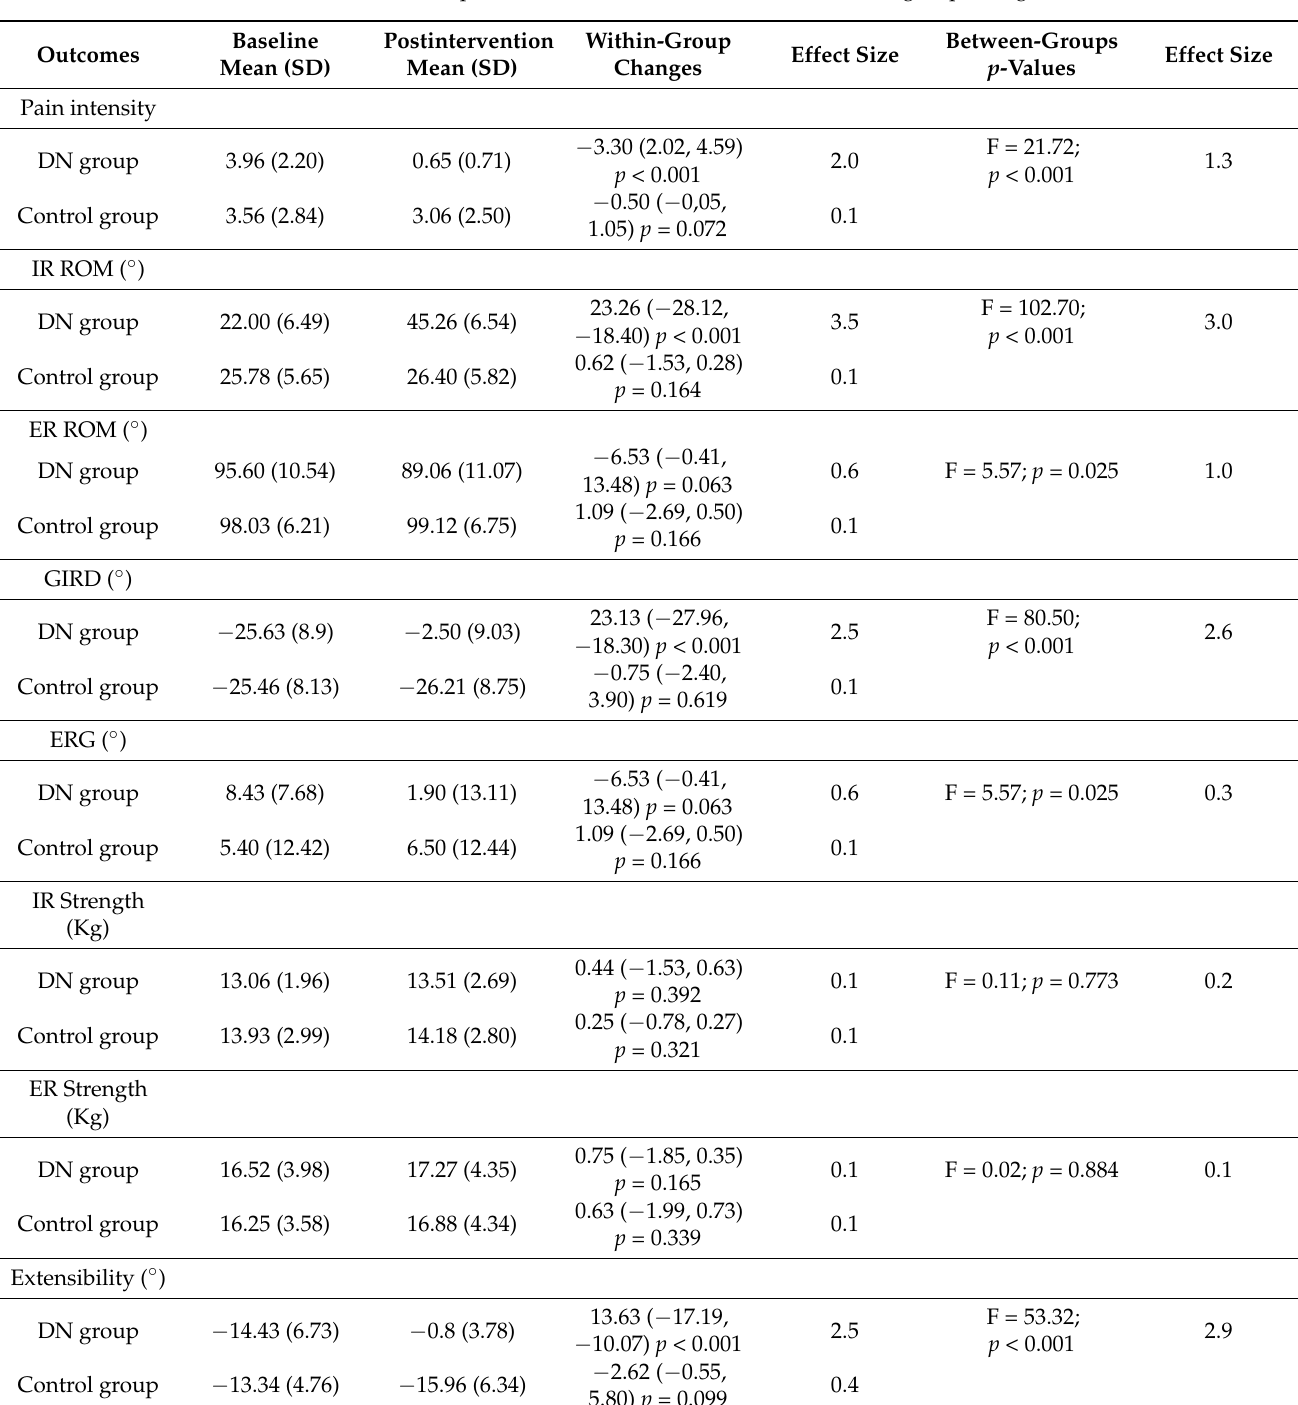
Table 2. Baseline and postintervention outcomes as well as within group